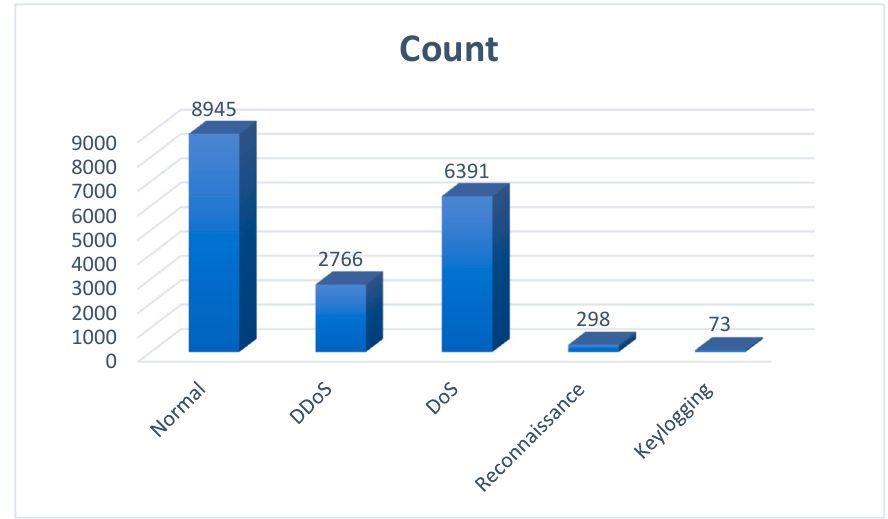
Figure 4. Statistics of attacks and normal behavior in the Bot-IoT dataset.